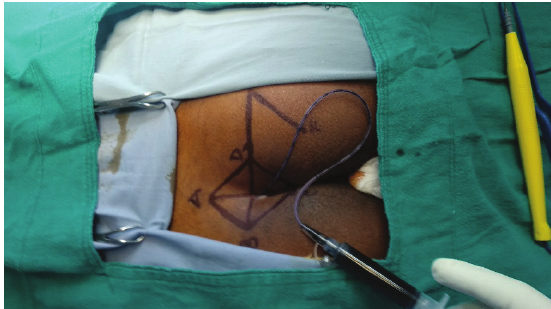
Figure 1: The preoperative marking of the surgical site